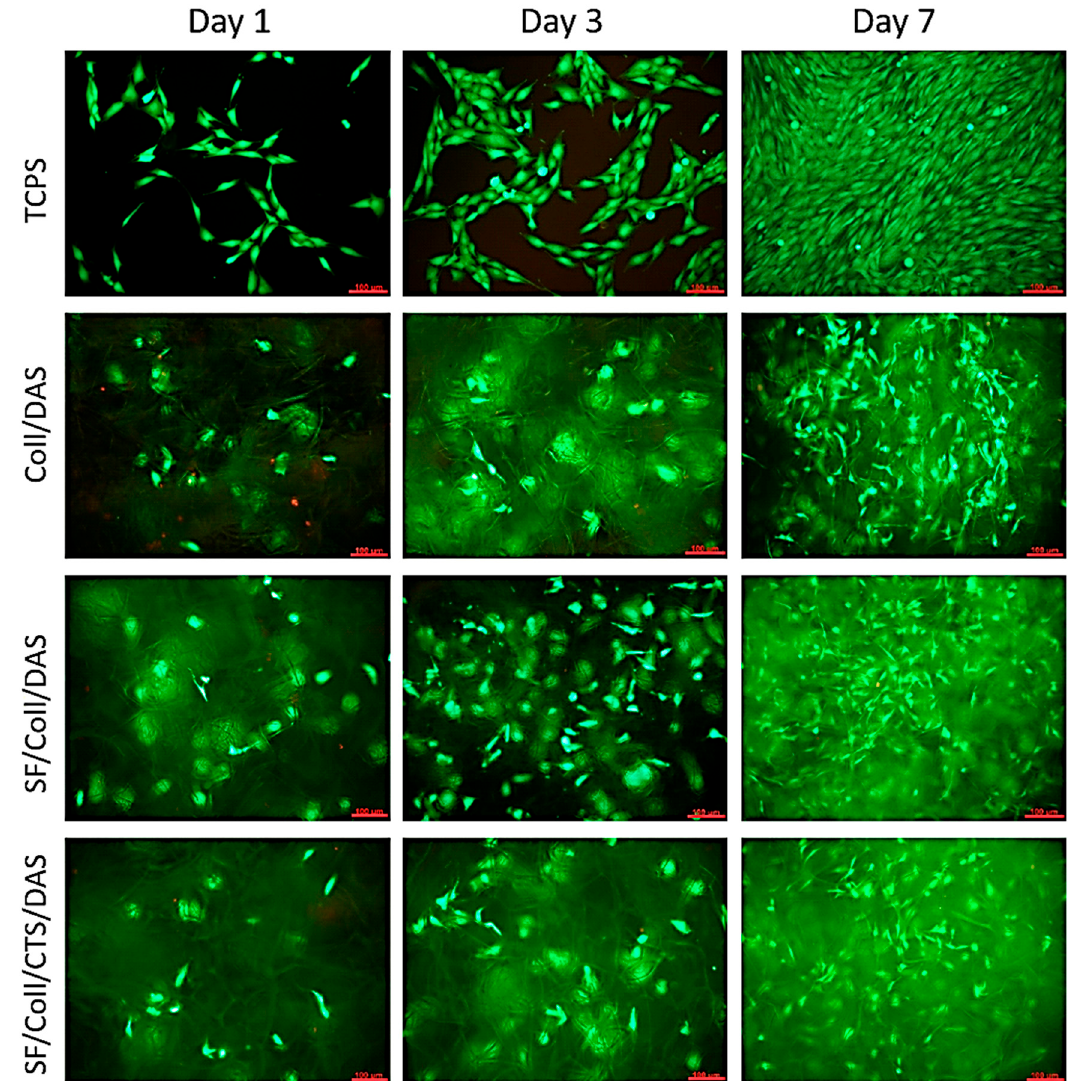
Figure 4. Images of MG-63 cells grown for 1, 3 or 7 days on Coll/DAS, SF/Coll/DAS and SF/Coll/CTS/DAS scaffolds and on control TCPS. Live/dead staining. Scale bar = 100 µm.